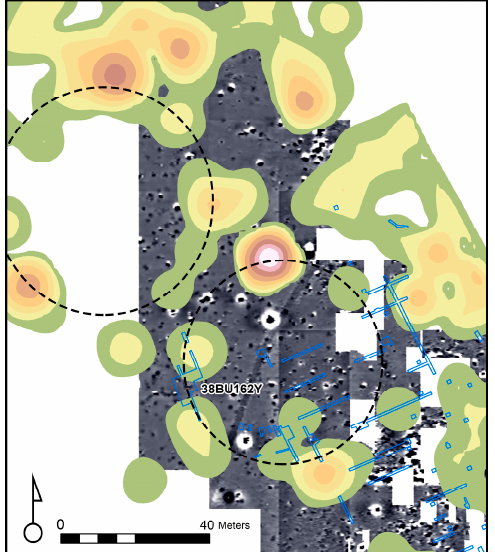
Figure 7. Two circular patterns identified in the distribution of Stallings ceramics as recorded through a shovel test survey including the location of excavation unit 38BU162Y where a potential Stallings period house floor was identified. The legend for the distribution of Stallings period ceramics is the same as that used in Figure 5. Distribution data is underlain by a gradiometer survey.